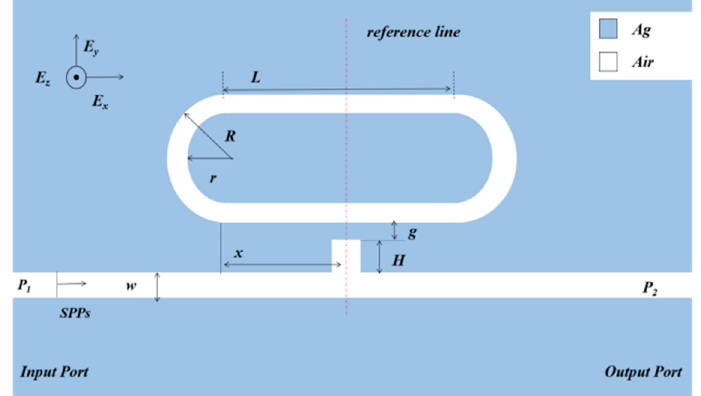
Figure 1. The geometric structure of the coupled racetrack ring resonator .